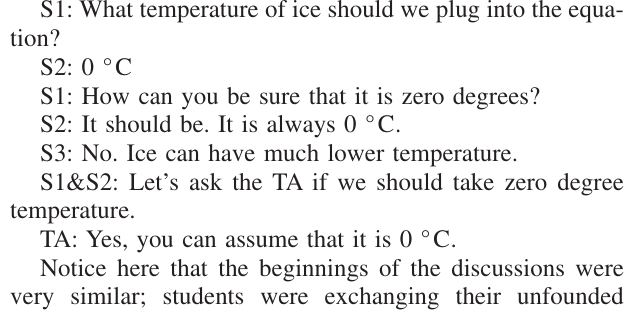
TABLE III. Sense-making